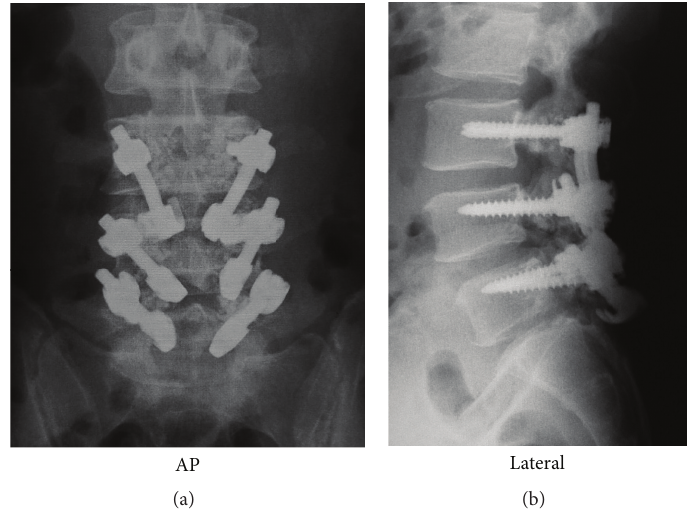
Figure 5: Three-level pars direct repair surgery. Note the pedicle screw and hook-rod system are used for each level.